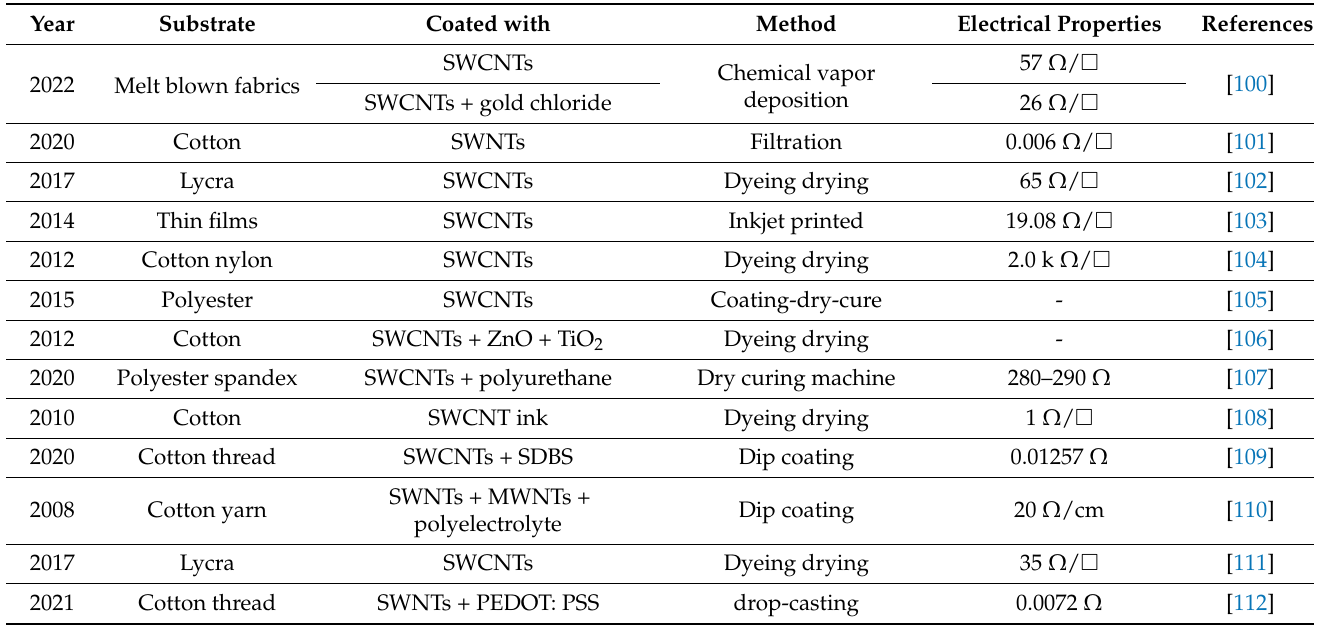
Table 4. Shows summary list of SWCNTs-based materials with details of their manufacturing processes and electrical